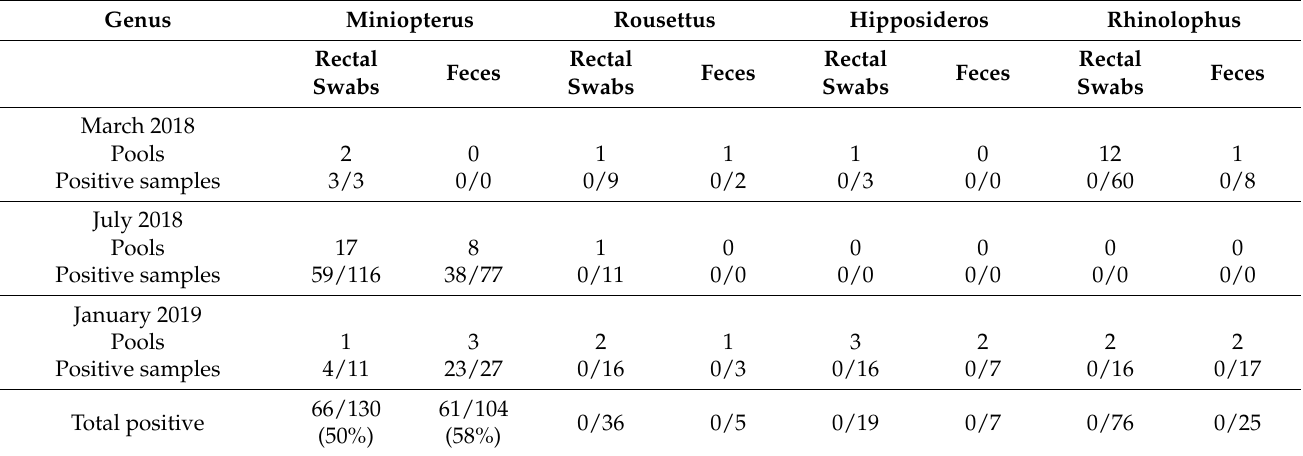
Table 5. Overview of the rectal swab and feces samples and pools per bat genus, collected at three different time points. Only samples from Miniopterus bats tested positive for the novel